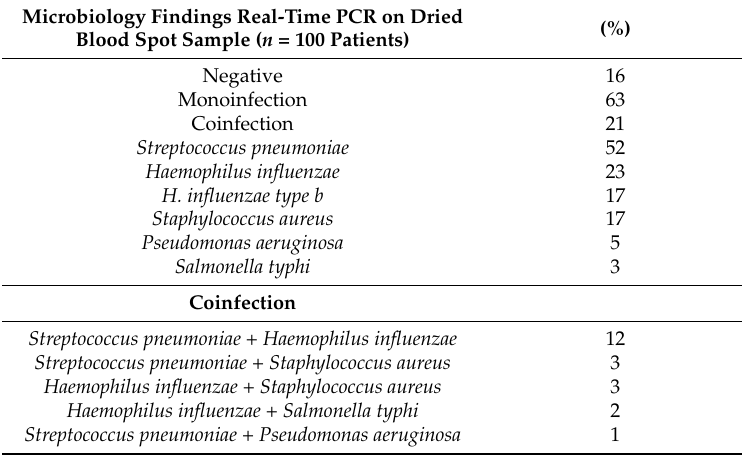
Table 2. Description of microbiological